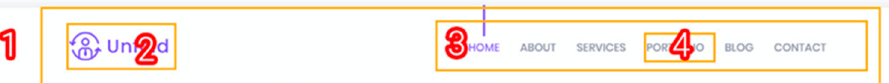
Figure 5. Example of duplicated block ignorance, when block number 4 represents any menu item of the menu (block No. 3), rather than labeling all menu items.